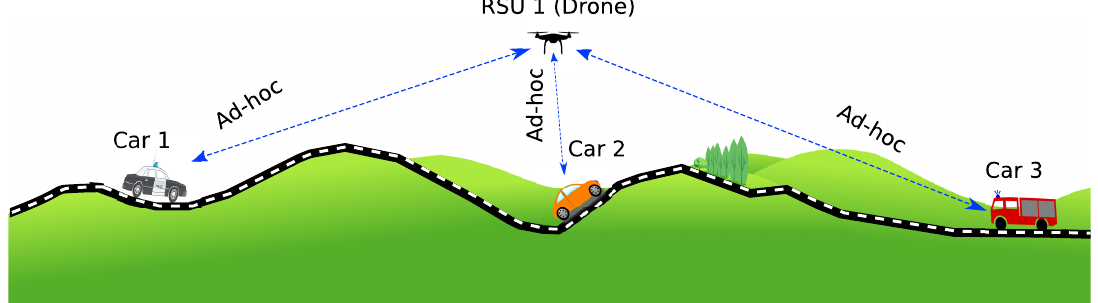
Figure 1. Unmanned Aerial Vehicle (UAV) acting as a Mobile Road Side Unit (RSU)